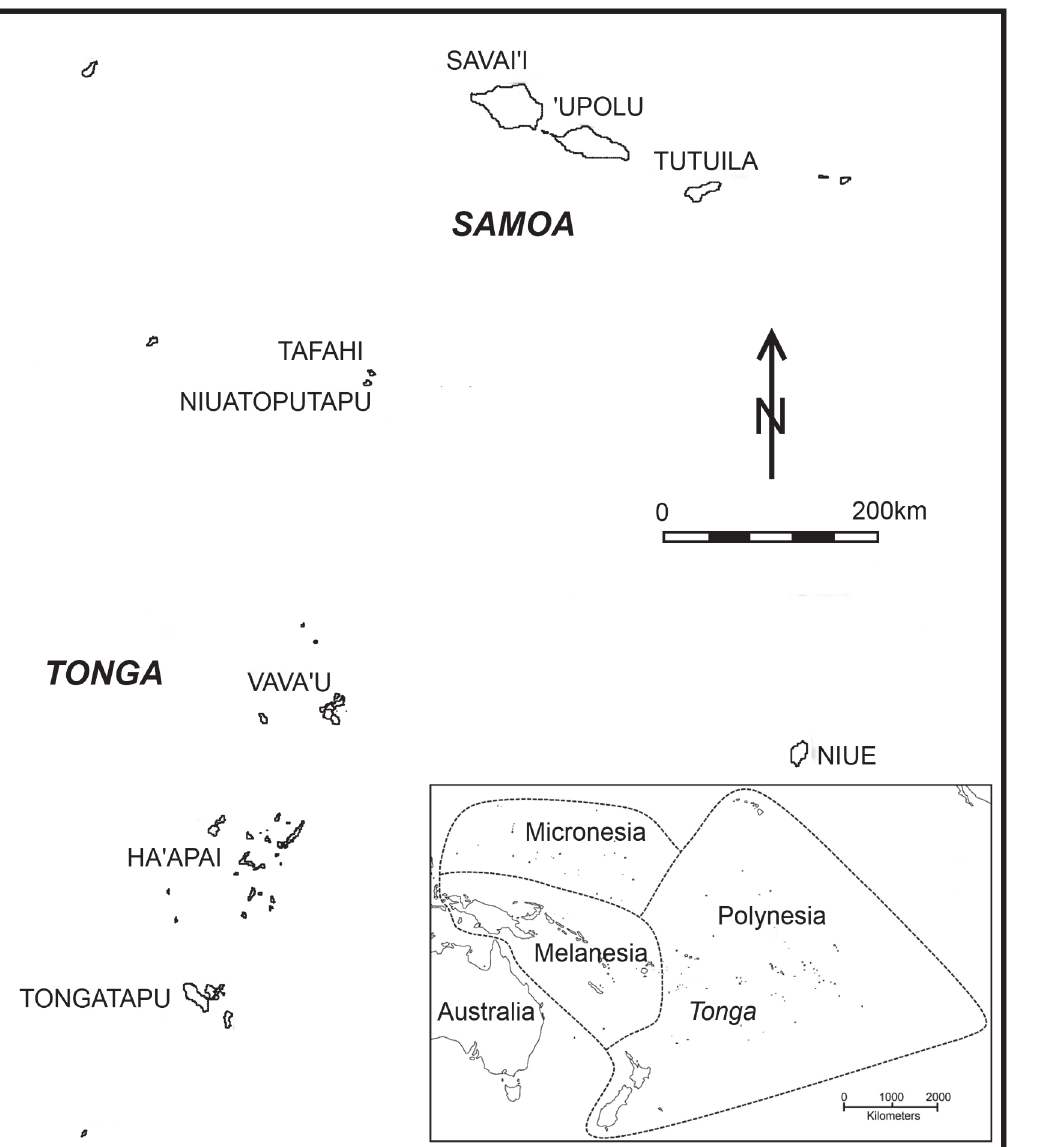
Fig 1. Map of Tonga illustrating island groups examined in